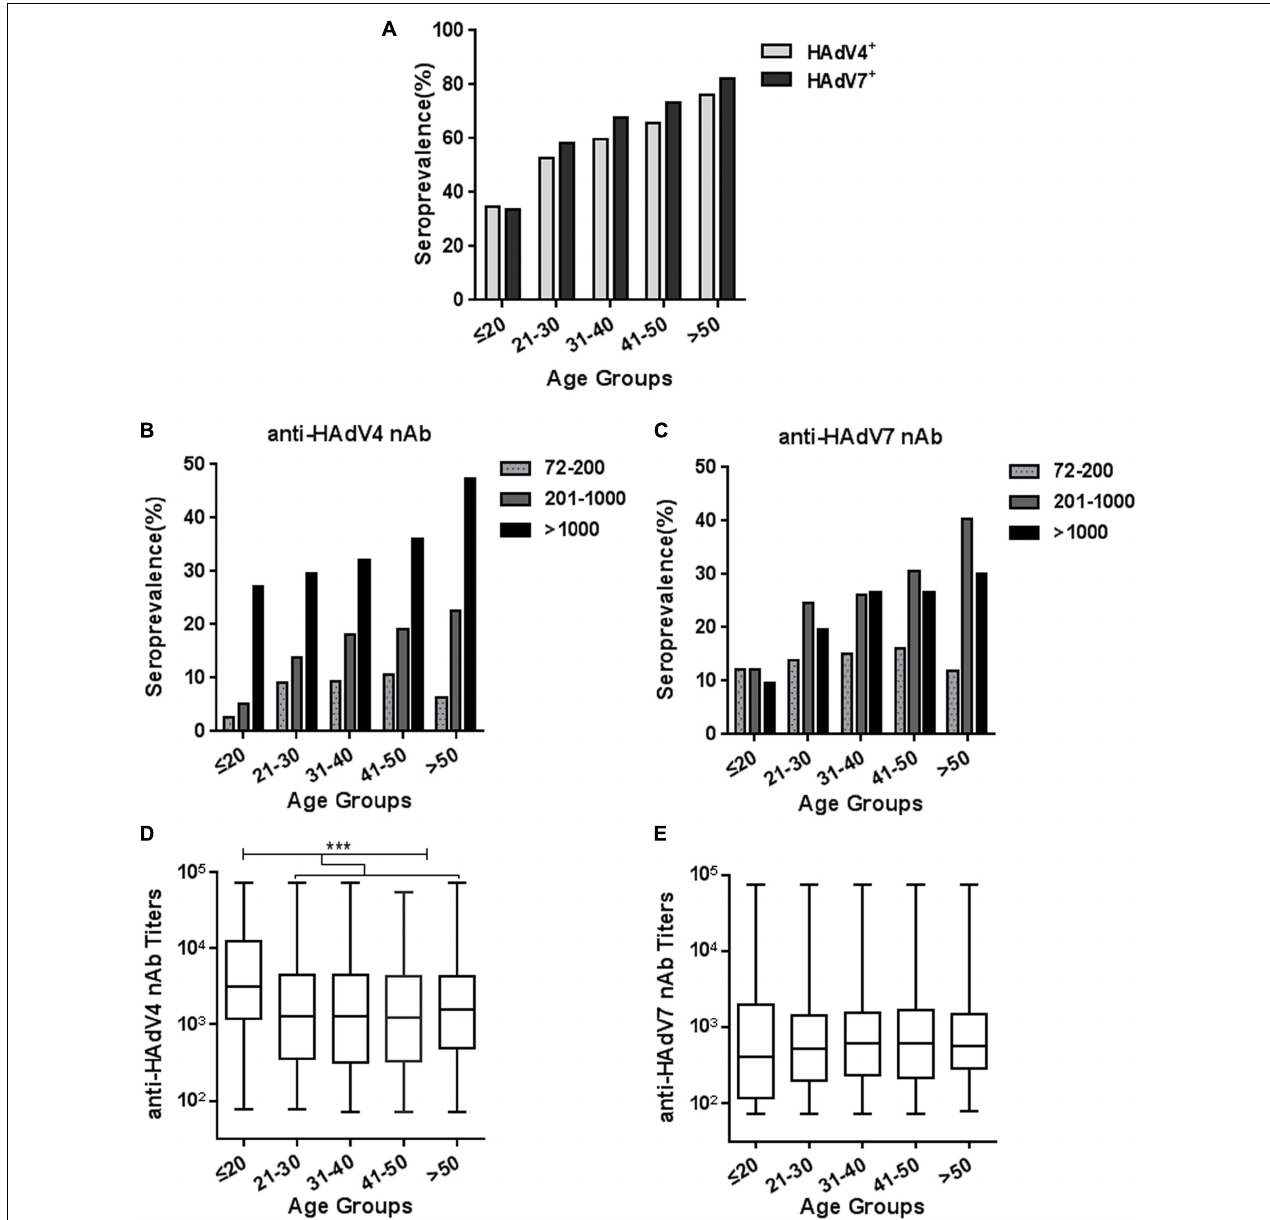
FIGURE 3 | Seroprevalence and titer distribution of anti-HAdV4 nAb and anti-HAdV7 nAb in different age groups. (A) The seropositivity rates of anti-HAdV4 nAb and anti-HAdV7 nAb in different age groups. The data were analyzed with Chi-square test for trend. (B,C) The distributions of the low (72–200), moderate (201–1000), and high ( > 1000) titers of anti-HAdV4 nAb (B) and anti-HAdV7 nAb (C) in different age groups. (D,E) The titers of nAb to HAdV4 (D) and HAdV7 (E) in different age groups. The data was analyzed with the Kruskal-Wallis test. ∗∗∗ P < 0.001.